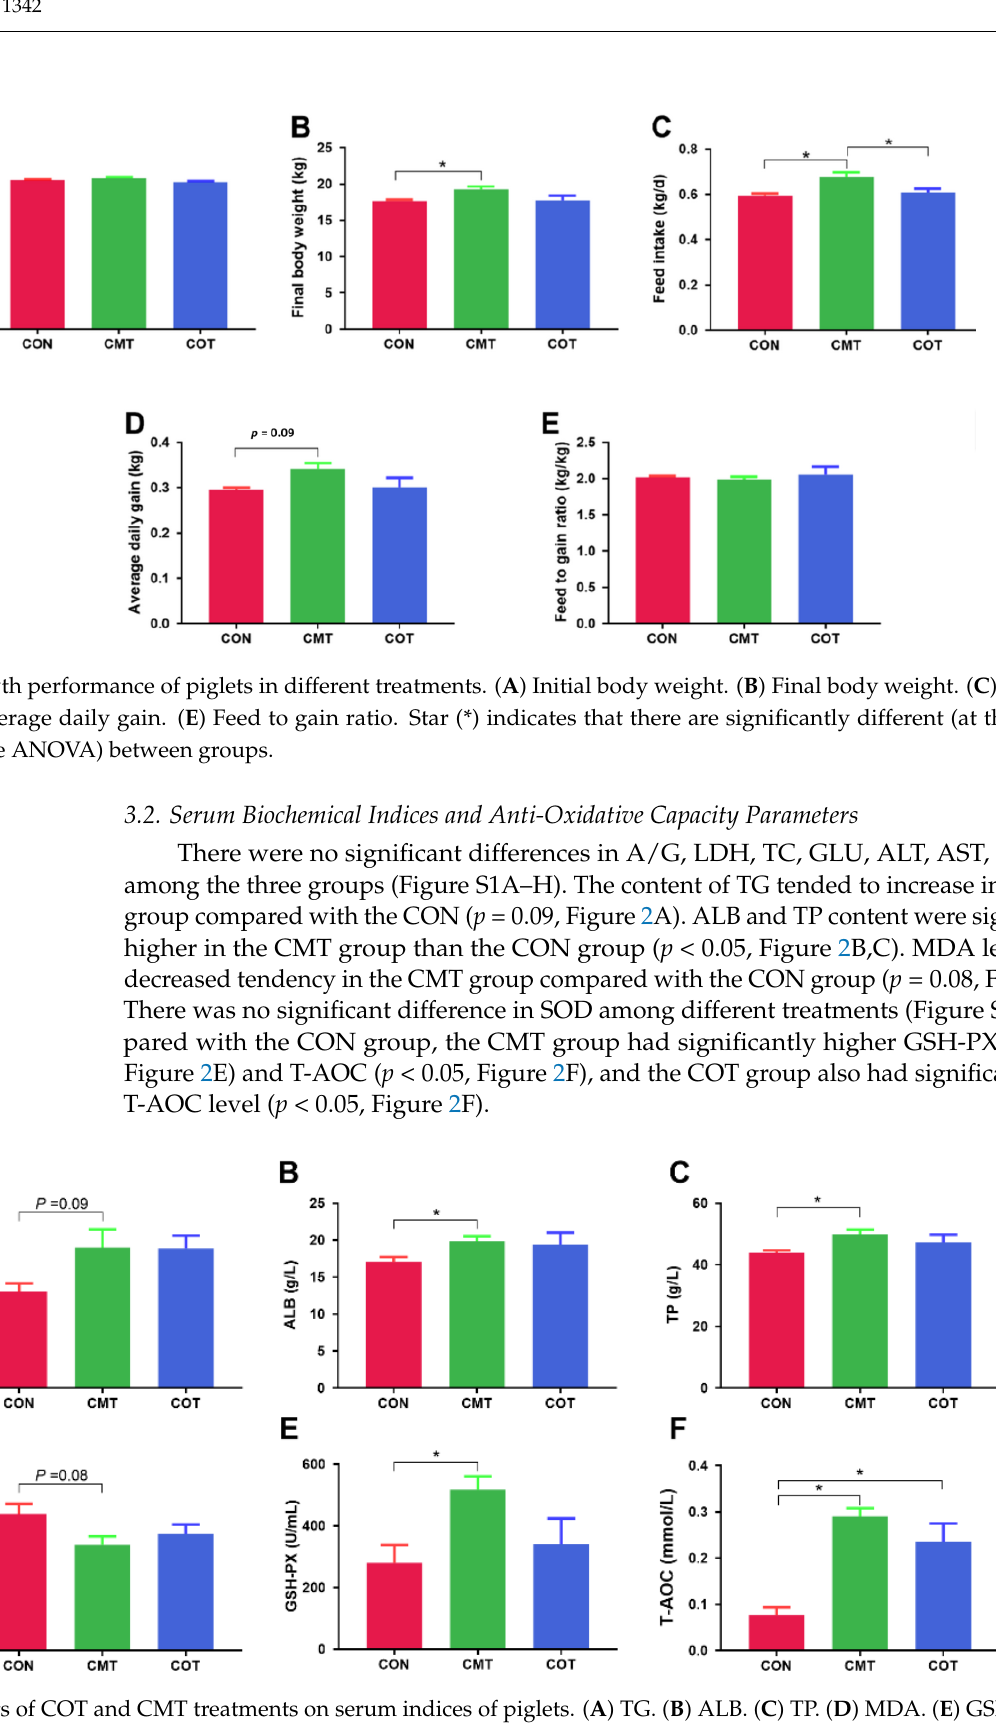
Figure 2. Effects of COT and CMT treatments on serum indices of piglets. ( A ) TG. ( B ) ALB. ( C ) TP. ( D ) MDA. ( E ) GSH-PX. ( F ) T-AOC. Star (*) indicates that there are significantly different (at the 5% threshold of the ANOVA) between groups.